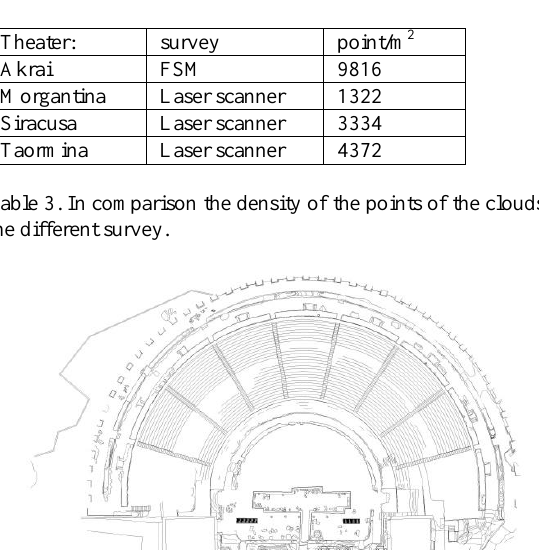
Figura 13 - Taormina, scan of the cavea The results are shown below in table 3.